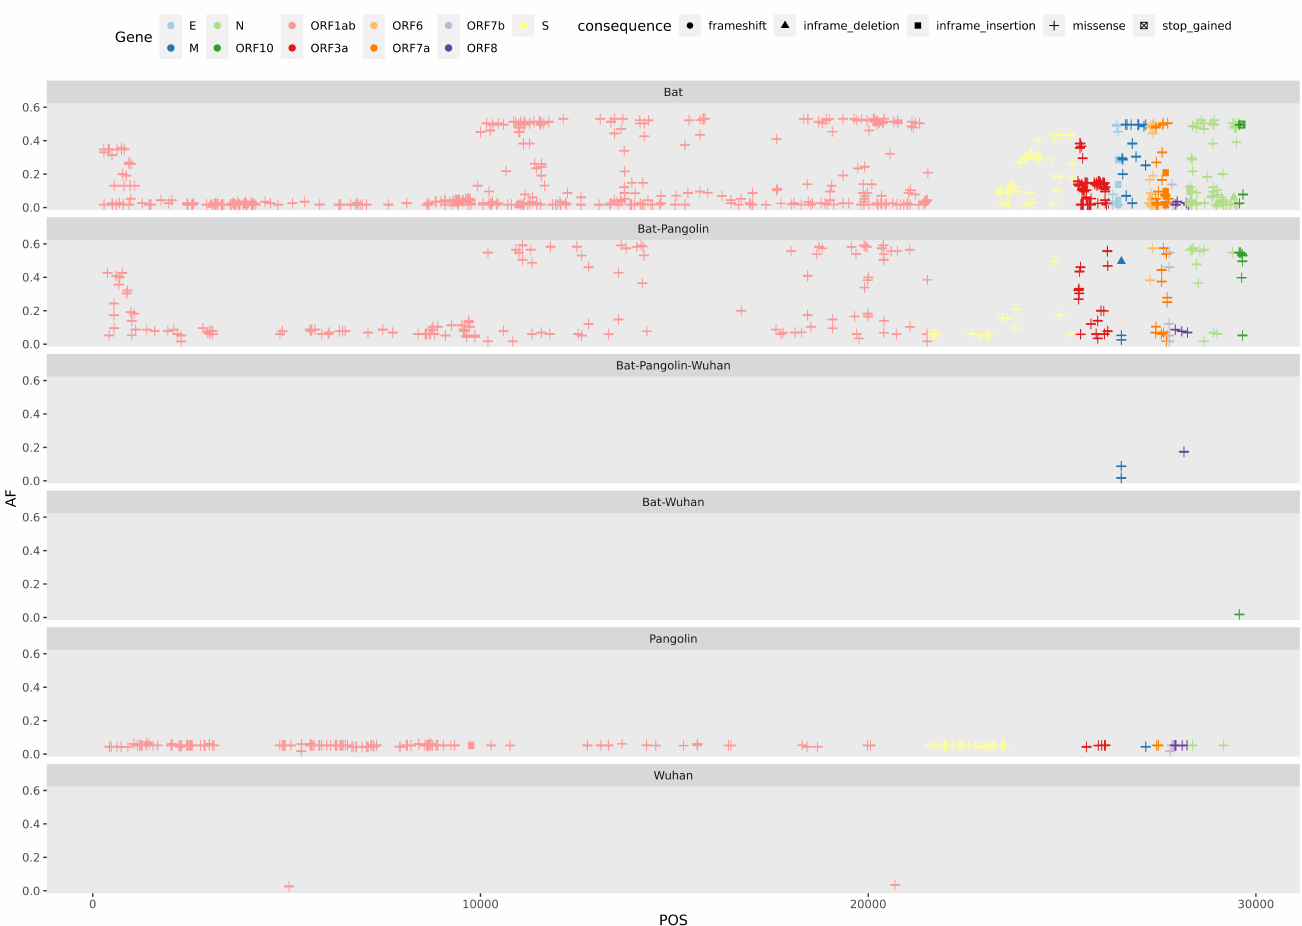
Figure A9. The coordinate map of all variants called against the human reference SARS-Cov-2 genome. Each horizontal track shows the variants present in the host-specie group. The colours shows the gene annotation origin of the variant and the shape